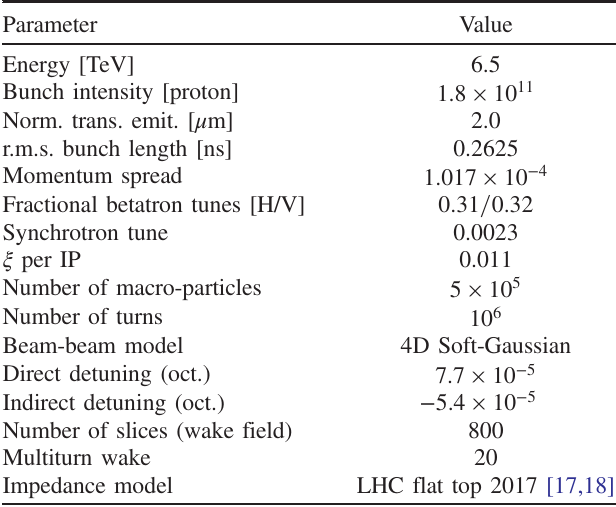
TABLE I. Numerical parameters used for the numerical model ( COMBI